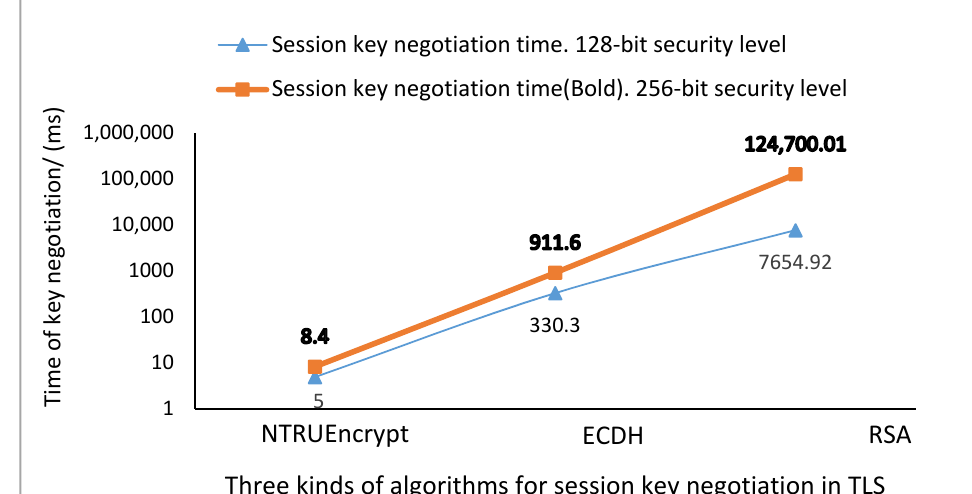
Figure 6. Relationship between key negotiation time and the security strength.